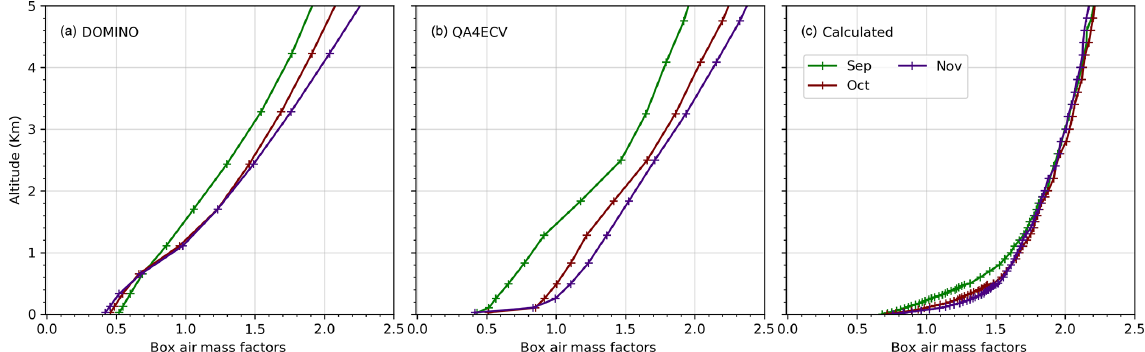
Figure D1. Monthly mean box air mass factors used in the DOMINO (a) and QA4ECV (b) NO 2 data products under clear-sky conditions (cloud fraction < 0 . 1) over Mohali for September (when the aerosol load is small) and October and November (when the aerosol load is high close to the surface). Panel (c) shows the corresponding box air mass factors calculated using MAX-DOAS aerosol extinction profiles.